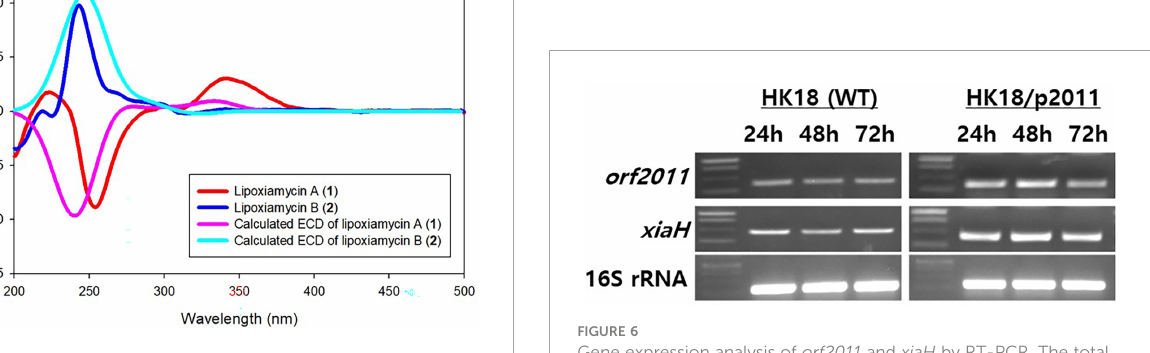
FIGURE 6 Gene expression analysis of orf2011 and xiaH by RT-PCR. The total RNAs were isolated from cultures of HK18 and HK18/p2011 at the times indicated. The 16S rRNA gene was used as a